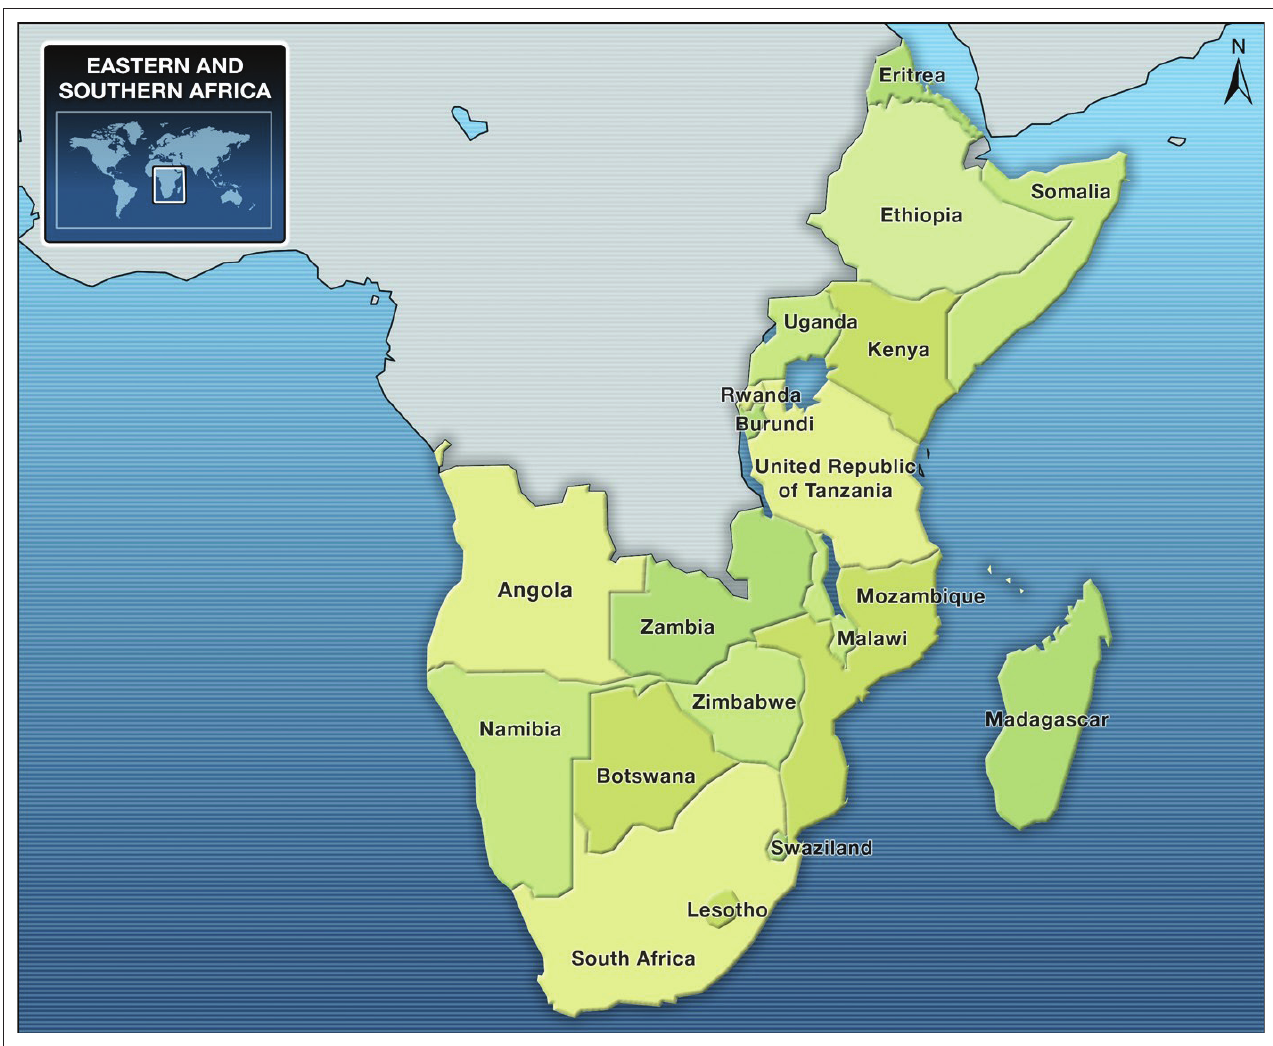
FIGURE 1: Map of Southeast